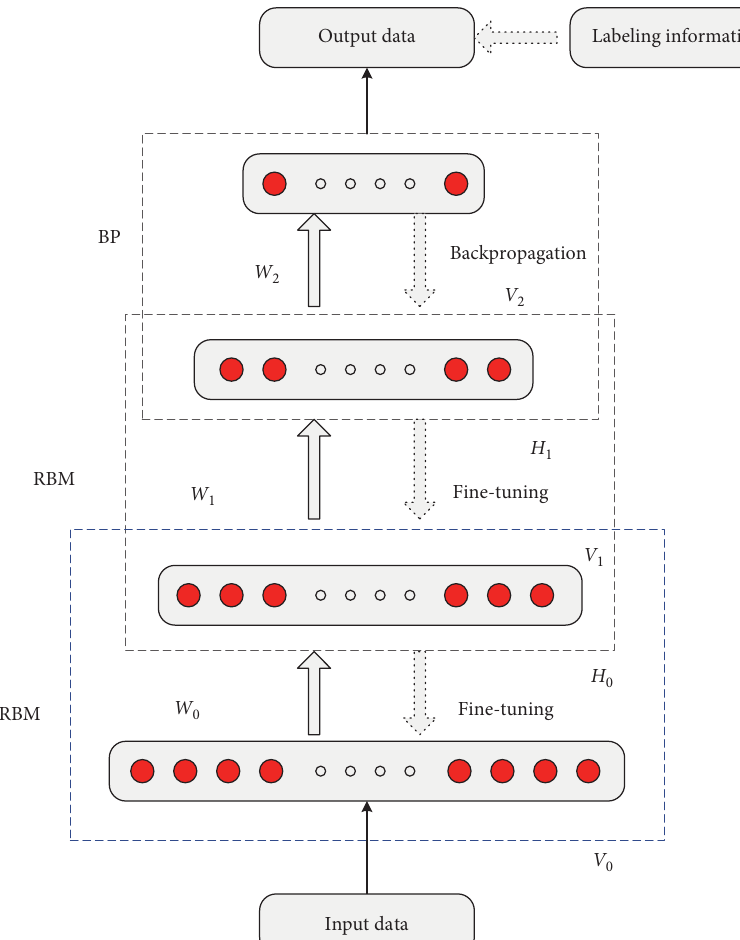
Figure 6: Structure diagram of double hidden layer DBN